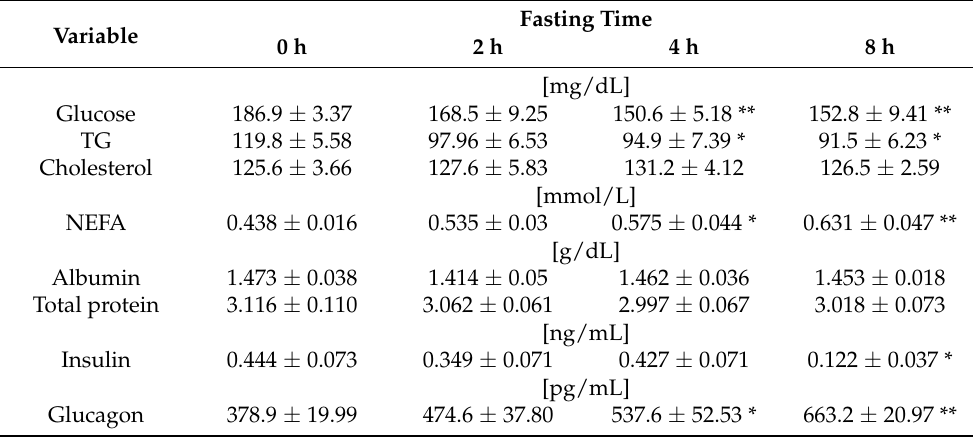
Table 3. Effect of fasting on the metabolic and hormonal profiles in broiler chickens. Results are shown as the means ± SEM for each value ( n = 8). Statistically significant changes are marked as * p < 0.05 and ** p < 0.01 compared to time 0.